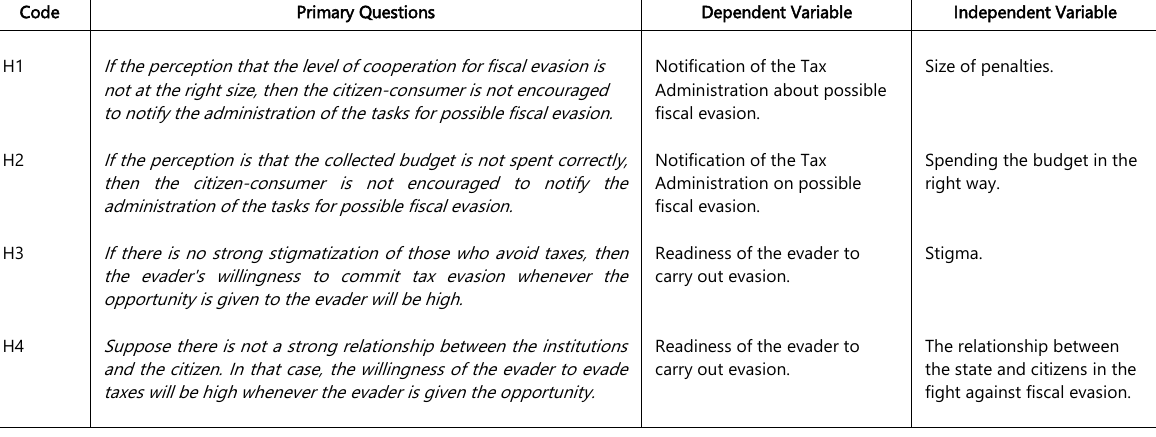
Table 1: Summary of Primary Research Questions (Source: Authors’